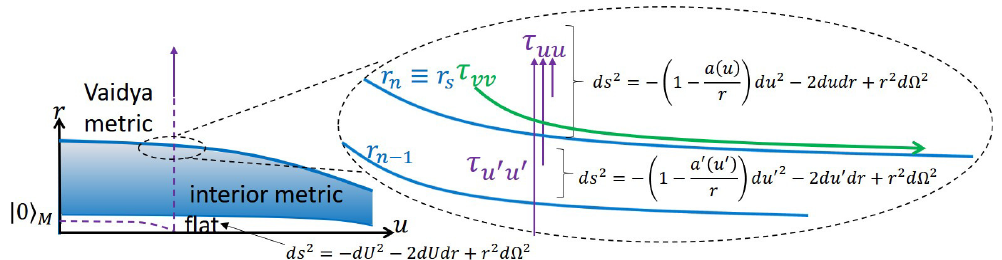
Figure 15. Collapsing matter in the outermost region and energy flow τ uu , τ vv . The shell is described as the outermost shell of the multi-shell model of Figure